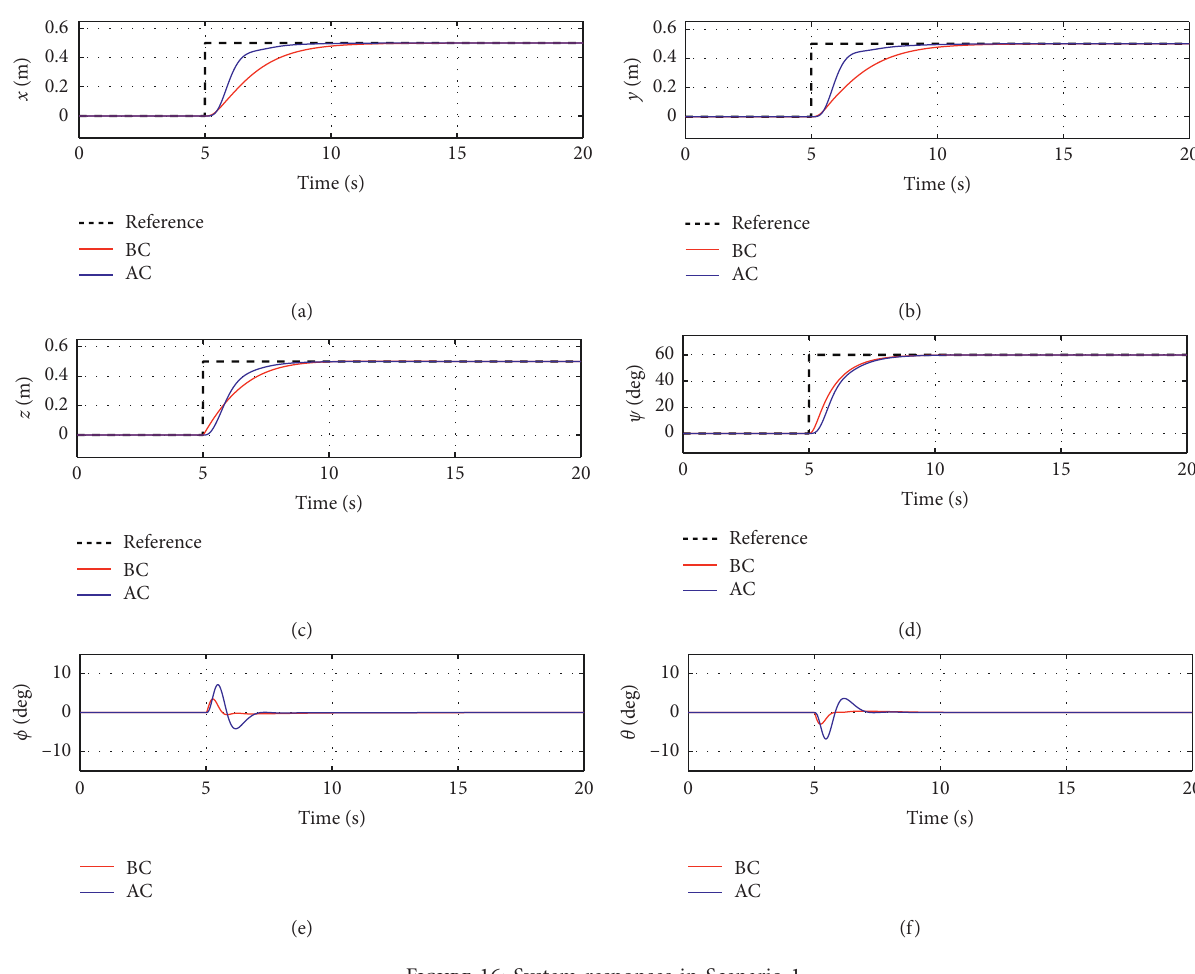
Figure 16: System responses in Scenario 1.